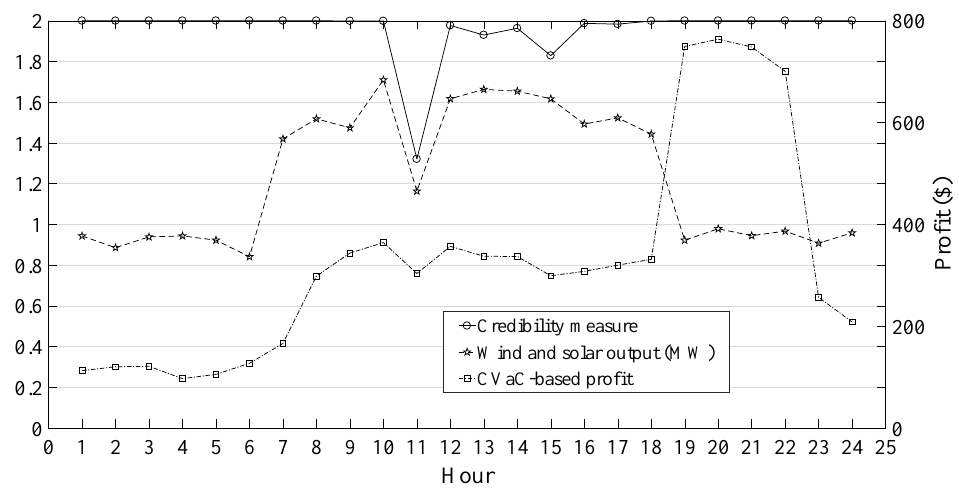
Figure 4. The characteristics of credibility measure, profit, and wind and solar power based on CVaC. Table 2. Optimal water discharge, power outputs, TOU price, and load demand with